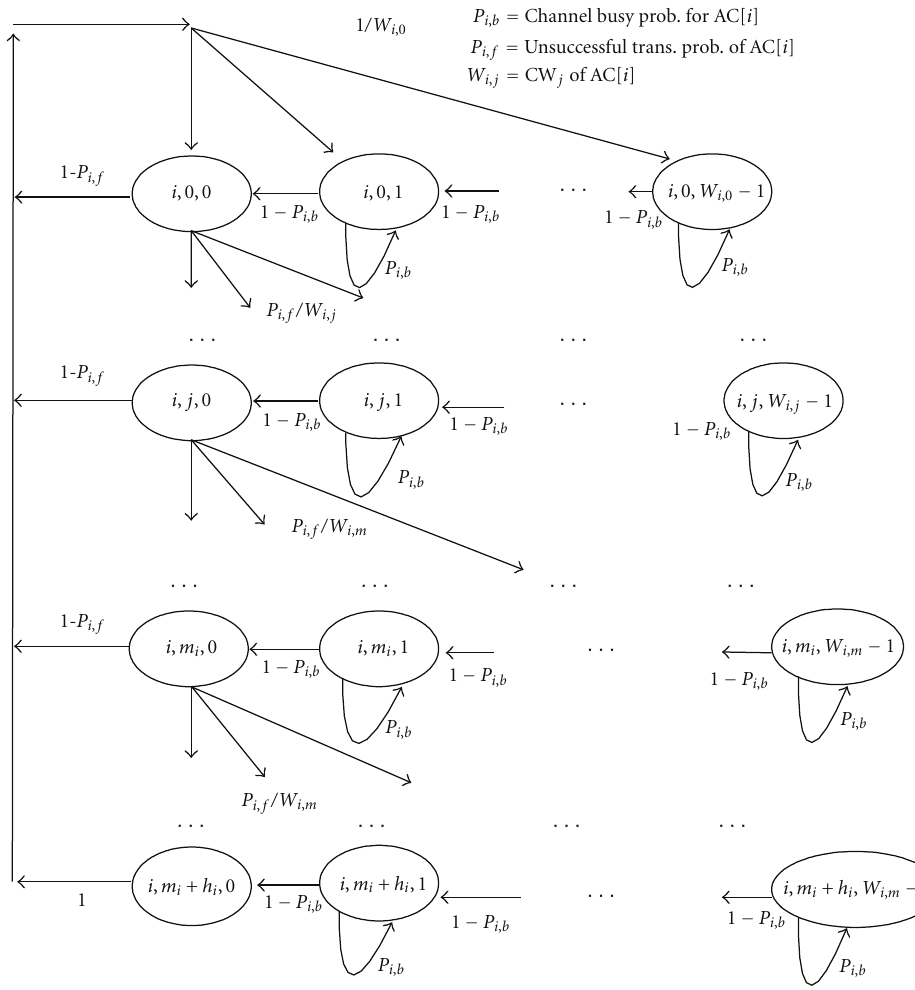
Figure 6: The transition diagram of the Markov chain model for one